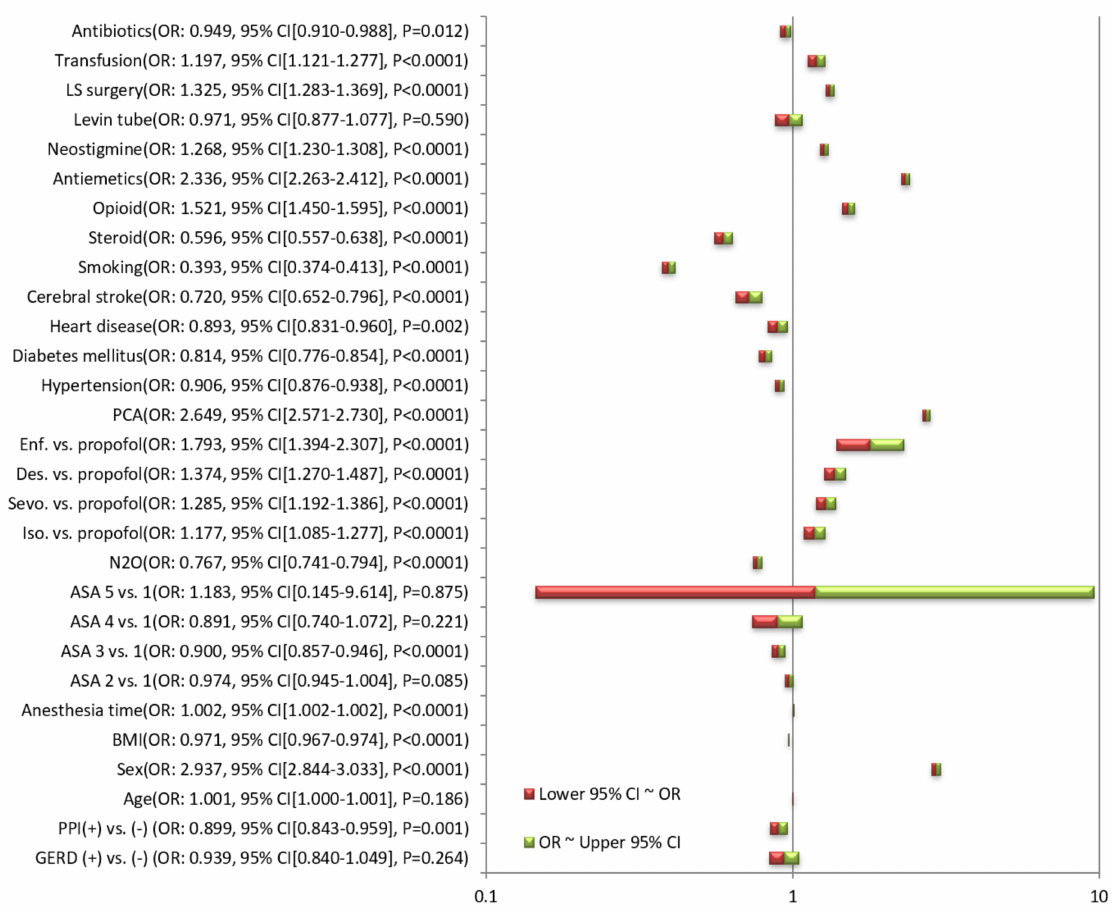
Figure 1. Unadjusted odds ratios for the occurrence of PONV of each variable obtained through logistic regression. GERD, gastroesophageal reflux disease; PPI, proton pump inhibitor; BMI, body mass index; ASA, American Society of Anesthesiologist physical status; Iso., isoflurane; Sevo., sevoflurane; Des., desflurane; Enf., enflurane; PCA, patient-controlled analgesia; LS, laparoscopic; OR, odds ratio; CI, confidence interval; PONV, postoperative nausea and